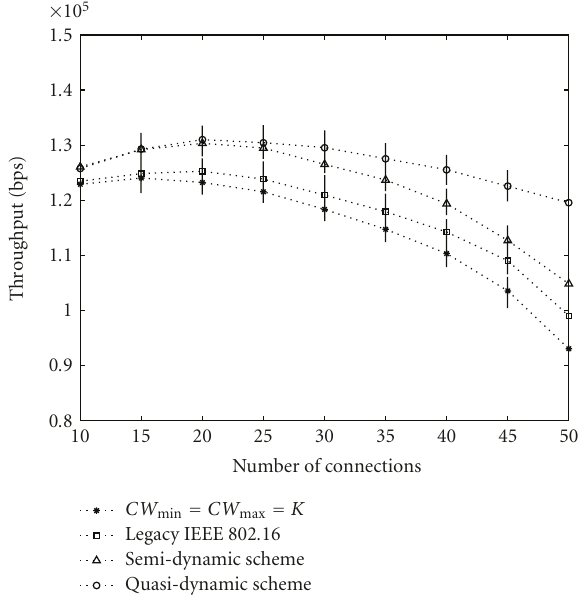
Figure 8: Achievable throughput versus number of